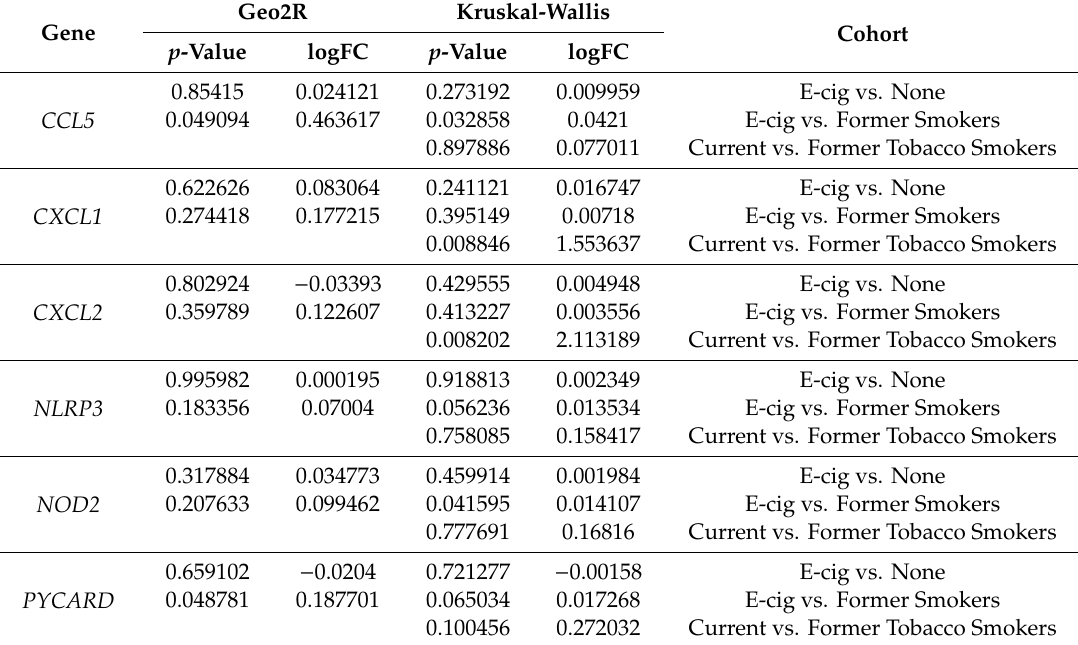
Table 2. Significantly dysregulated inflammasome-related gene